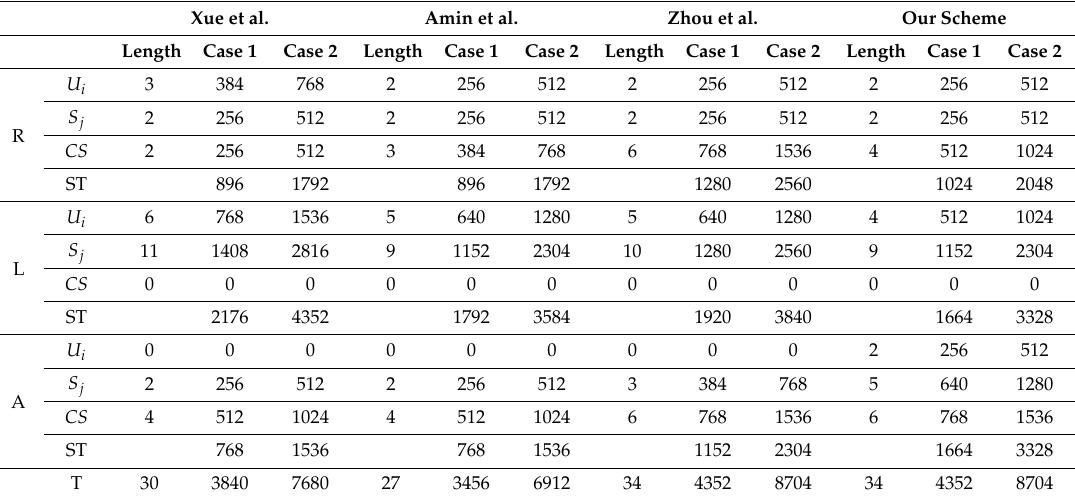
Table 5. Communication cost comparison.